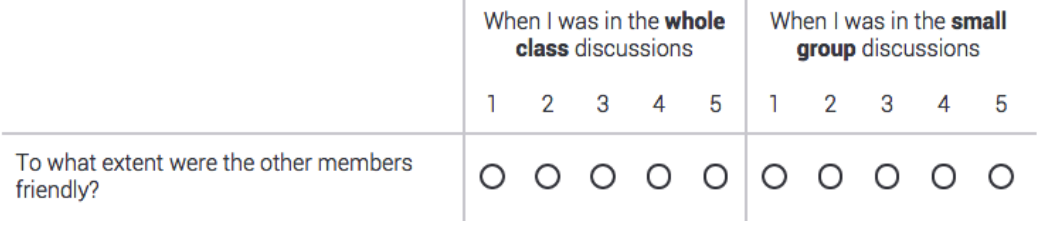
Figure 1. Screen capture of the example survey